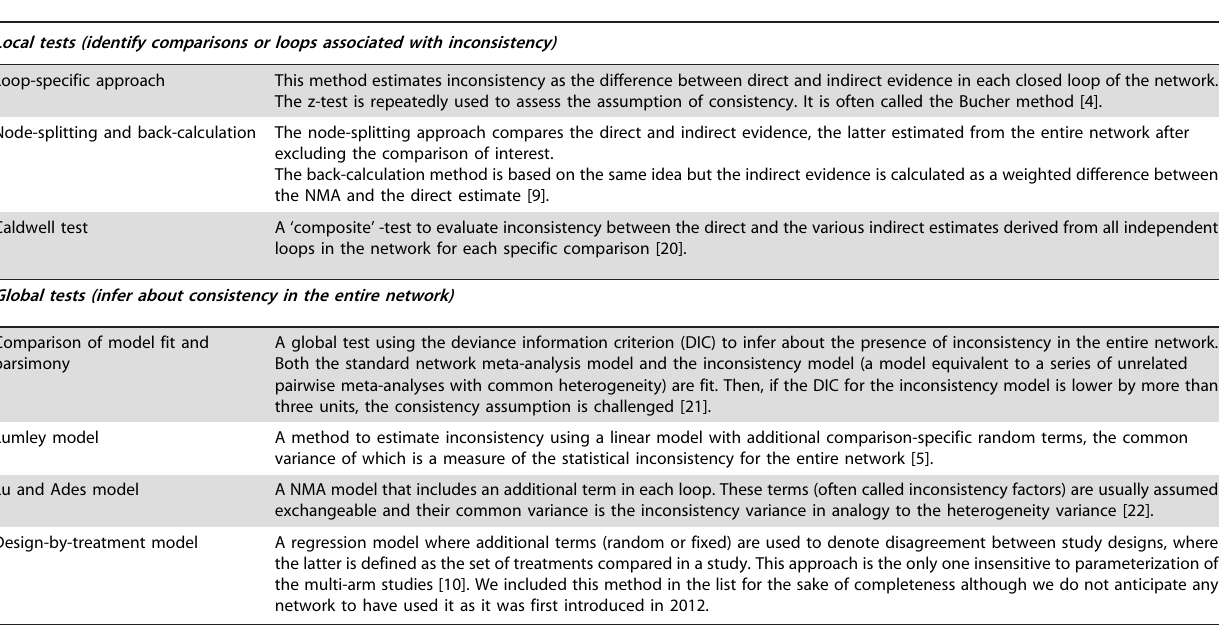
Table 2. Description of statistical methods used to evaluate the consistency